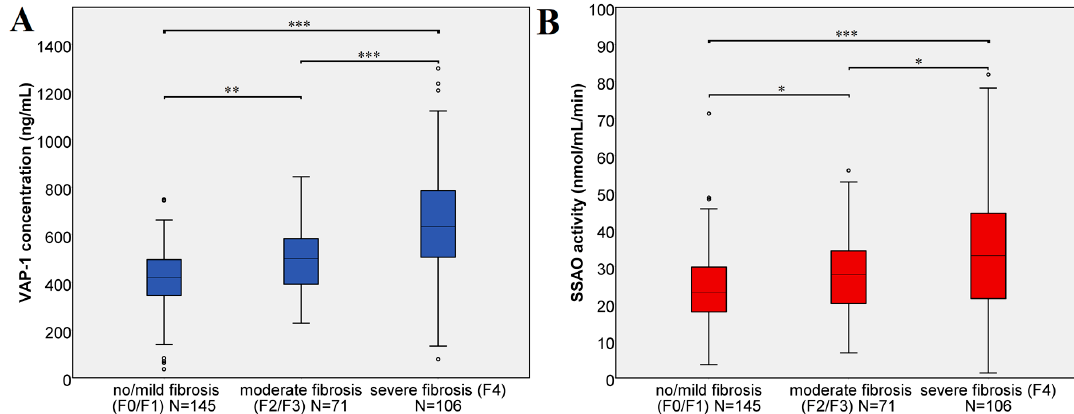
was differentiated according to the VAP ‐ 1 concentration ( p = 0.003 and p < 0.001 respectively).